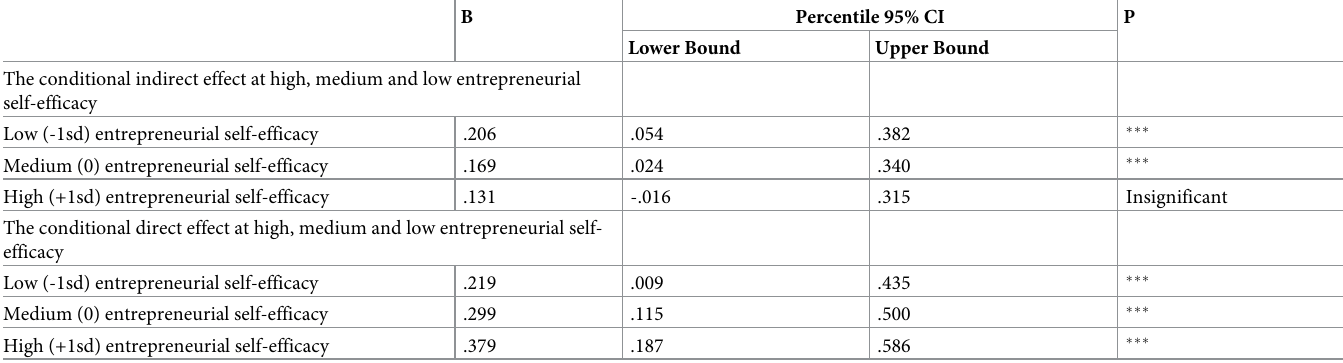
Table 5. Conditional direct and indirect effect of cognitive flexibility on entrepreneurial intention through entrepreneurial self-efficacy.